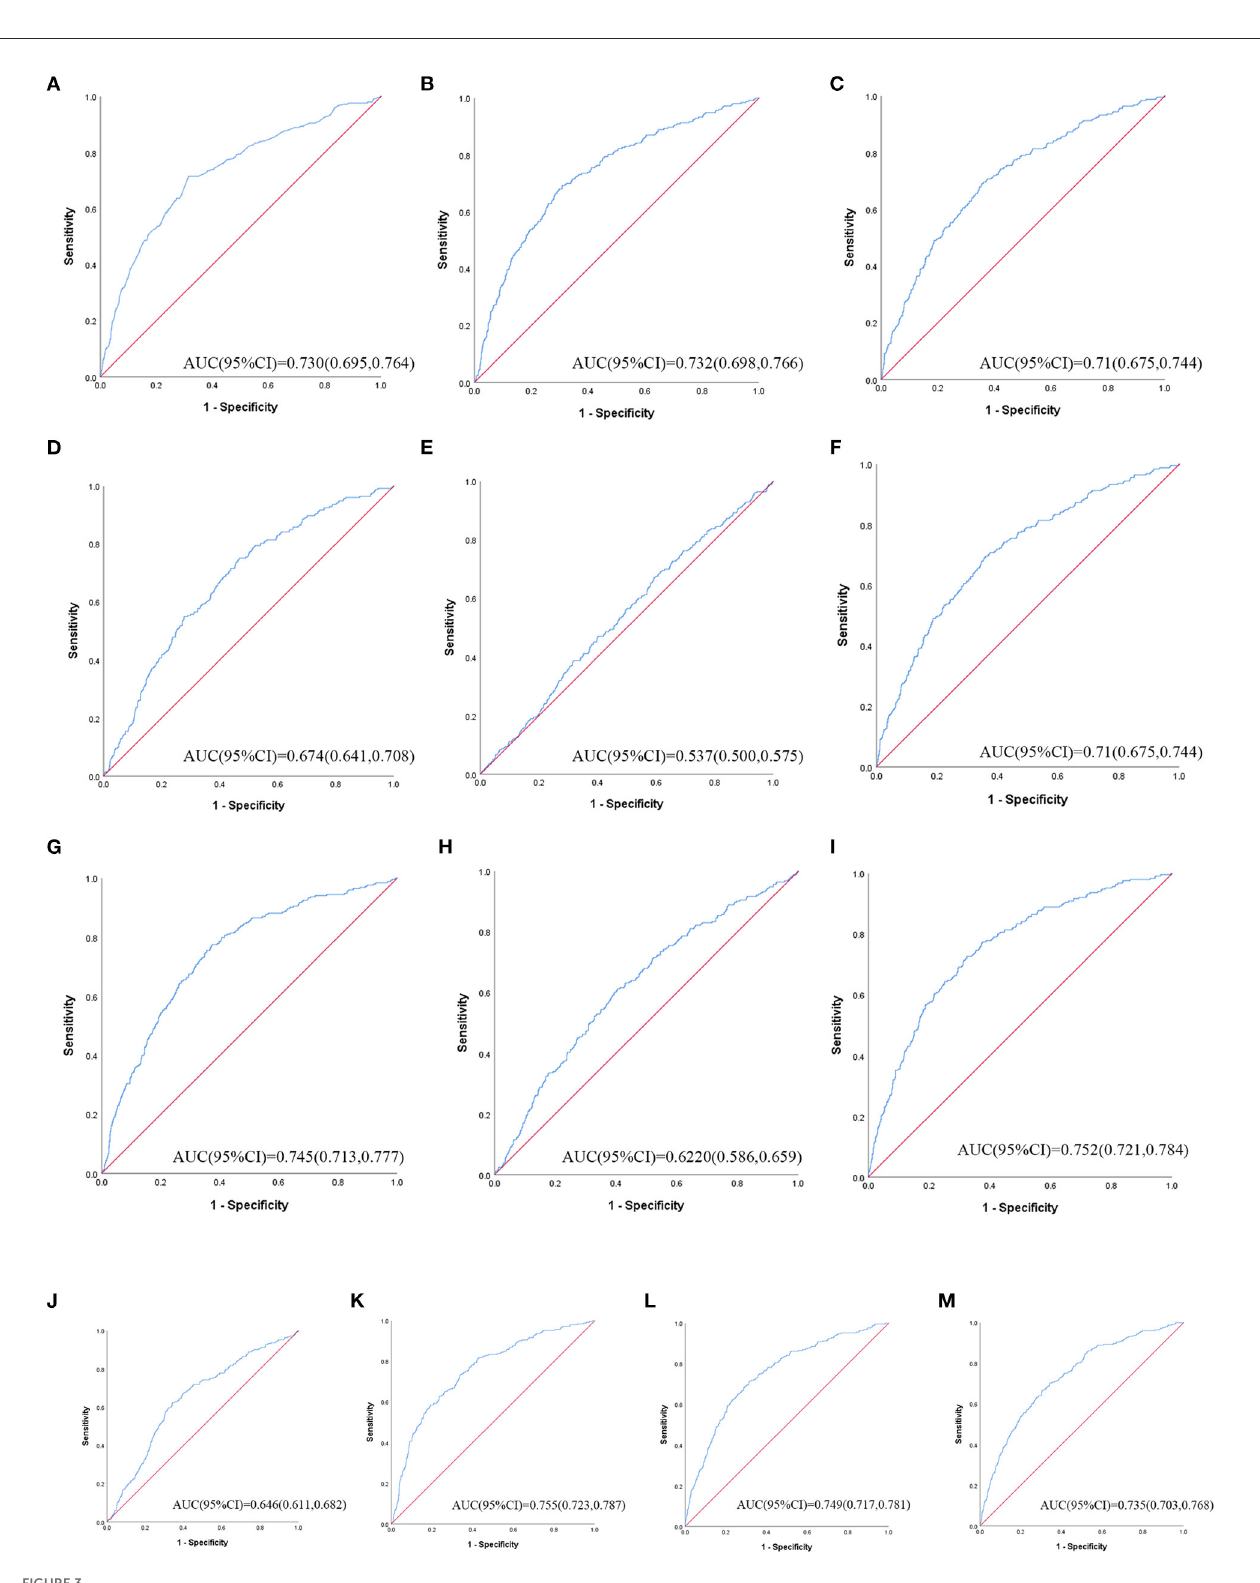
FIGURE3 The ROC curves of each indicator in the prediction of MetS risk in male. (A) = WC, (B) = BMI, (C) = WHtR, (D) = VAI, (E) = ABSI, (F) = BRI, (G) = LAP, (H) = CI, (I) = CVAI, (J) = TyG-index, (K) = TyG-BMI, (L) = TyG-WC, (M) = TyG-WHtR.